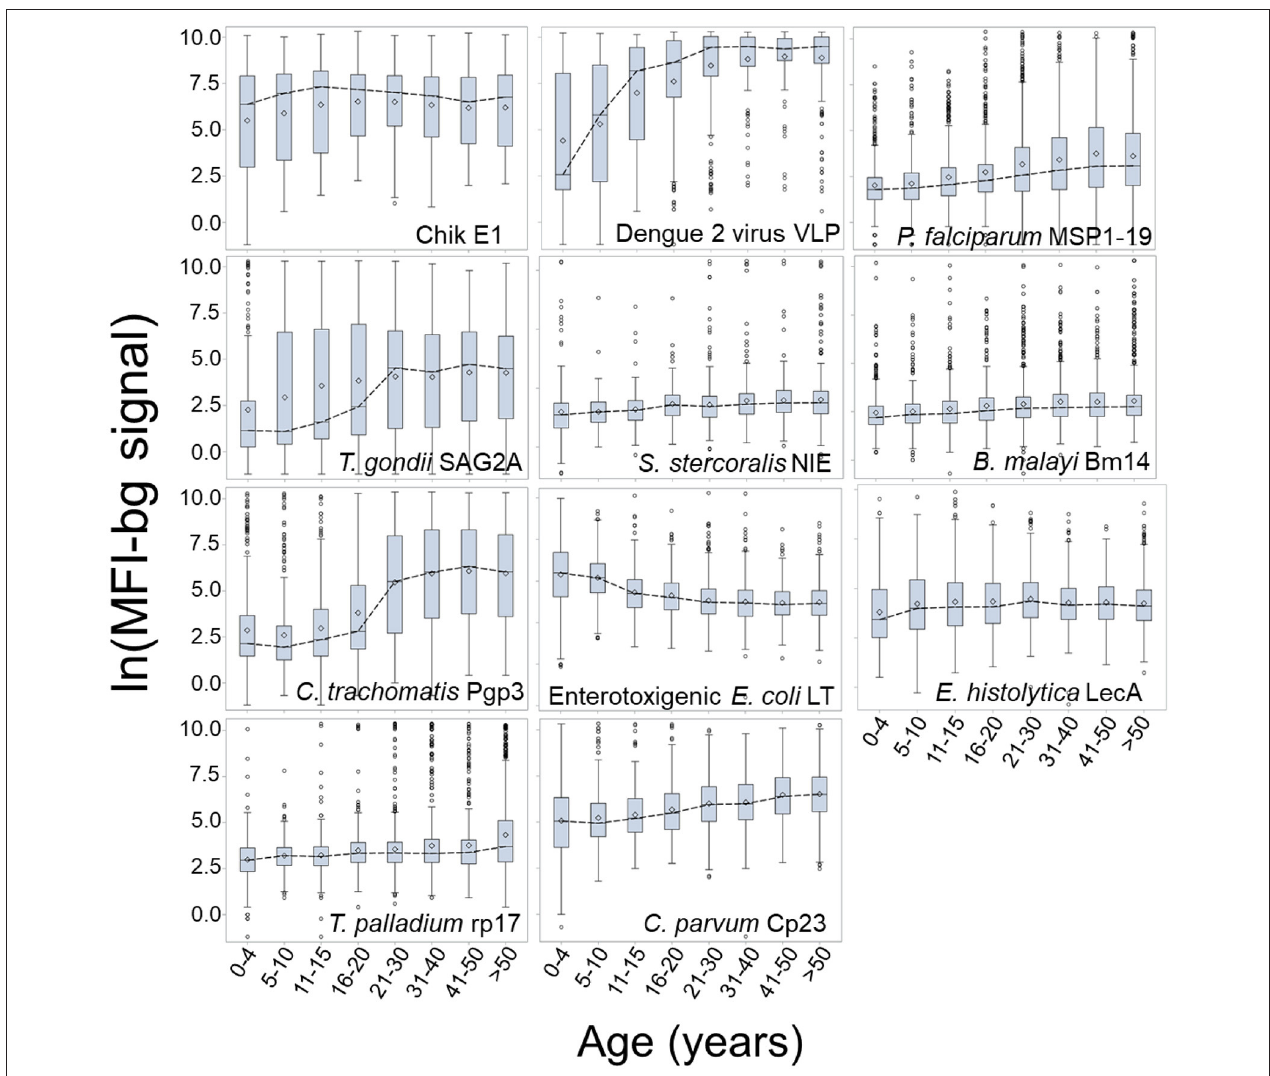
FIGURE 3 | Dynamics in MFI-bg IgG Signal by Age for Selected Antigens. Data shown as boxplots for log-transformed median fluorescence intensity minus background (MFI-bg) assay signal for selected antigens by age category. Boxplots are displayed as interquartile rage (IQR) with whiskers extending 1.5x above and below IQR and circles for observations beyond this. A dashed line connects boxplot